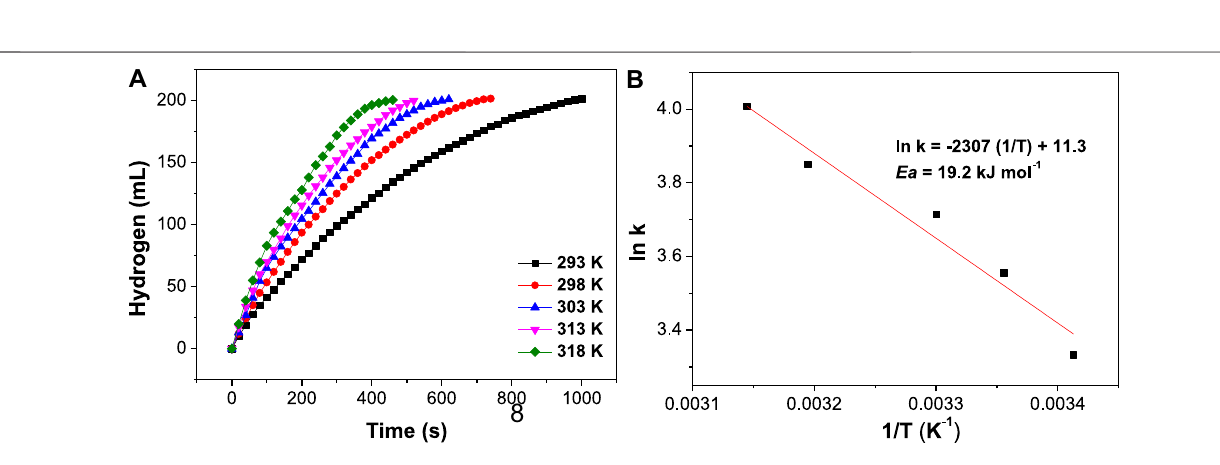
Frontiers in Materials |